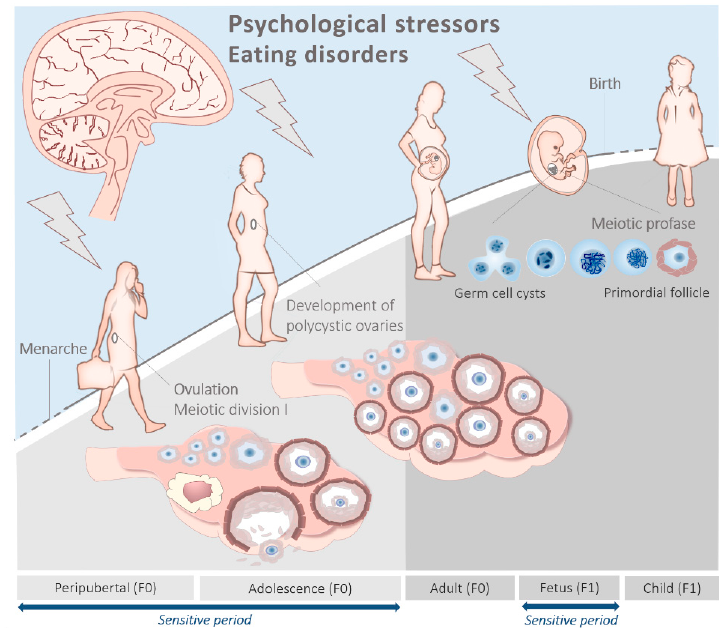
Figure 1. The impact of alternating recurrent periods of psychological stressors and eating disorders in the critical periods during the life course in the developmental origins of polycystic ovary syndrome (PCOS). Modified from Steegers et al.’s Textbook of Obstetrics and Gynaecology; a life course approach, 2019